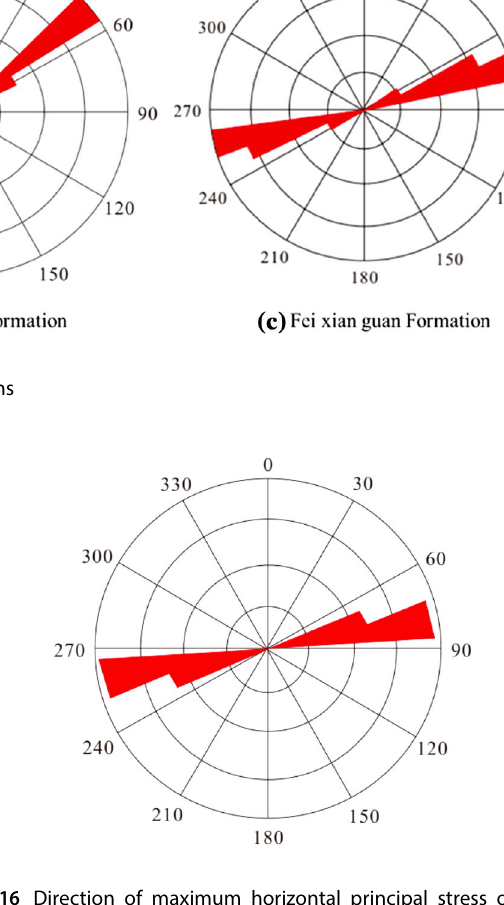
Fig. 16 Direction of maximum horizontal principal stress of wall caving azimuth statistics in the Feixianguan